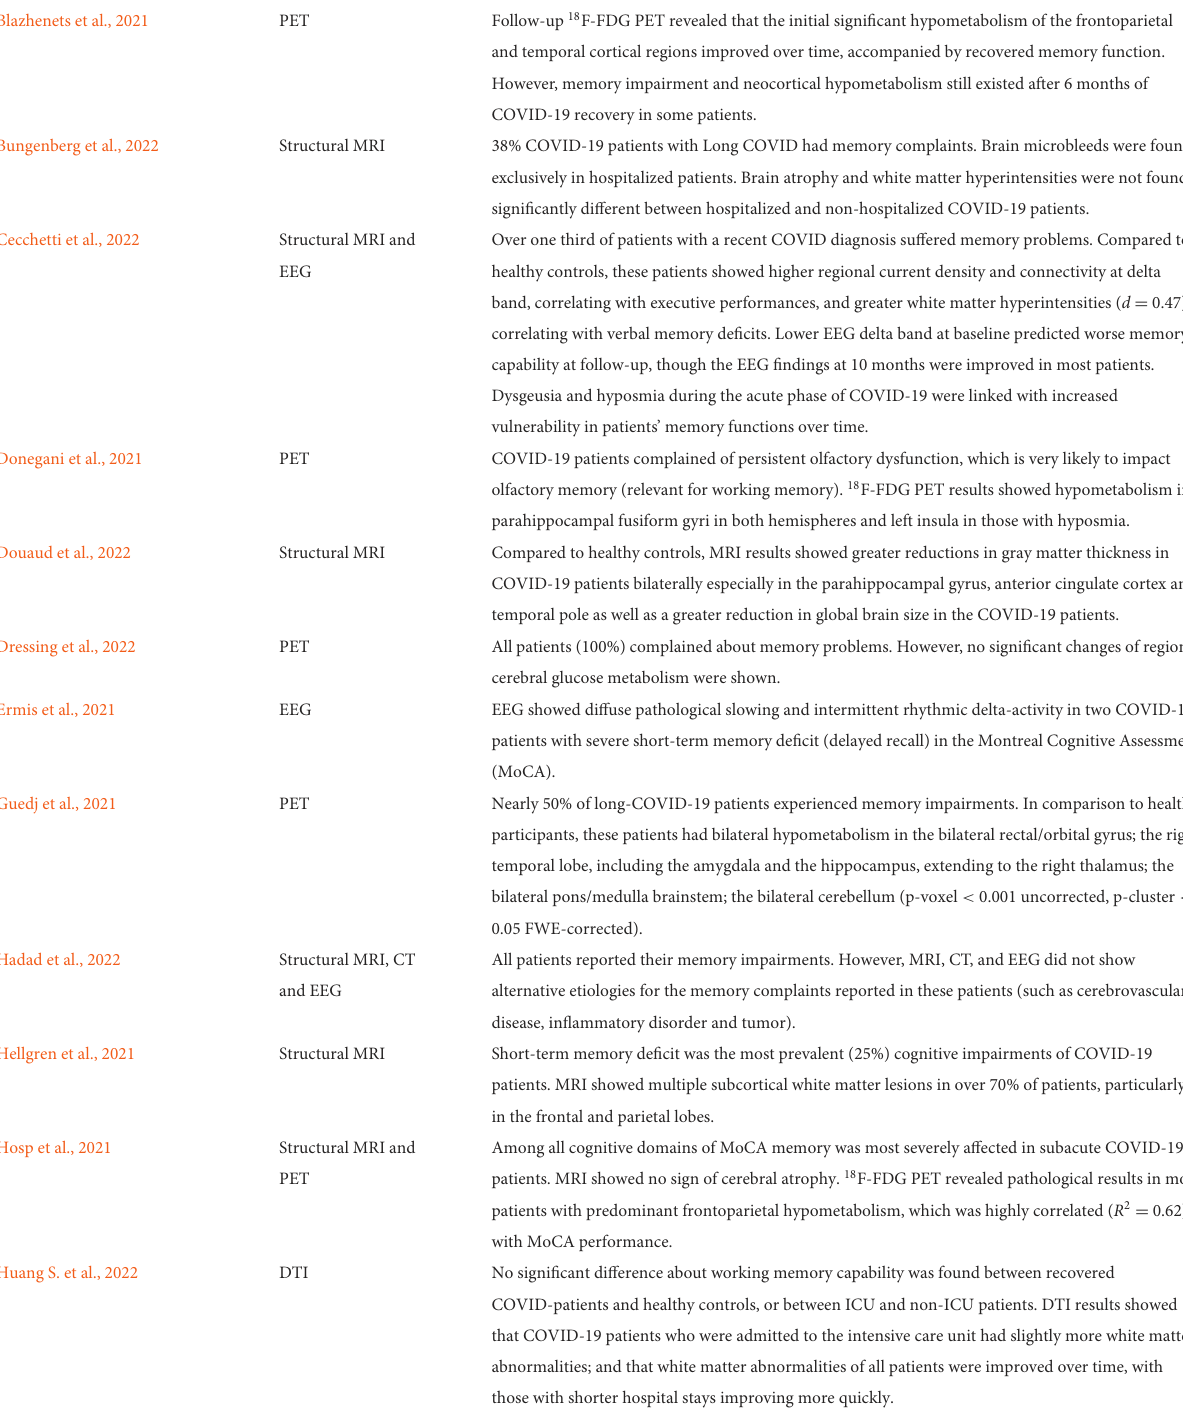
TABLE 2 Summary of study procedures and findings of included original